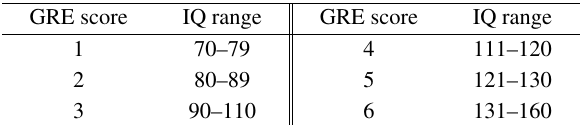
Table 4 Mapping of GRE writing sample scores to IQ score ranges [35] .